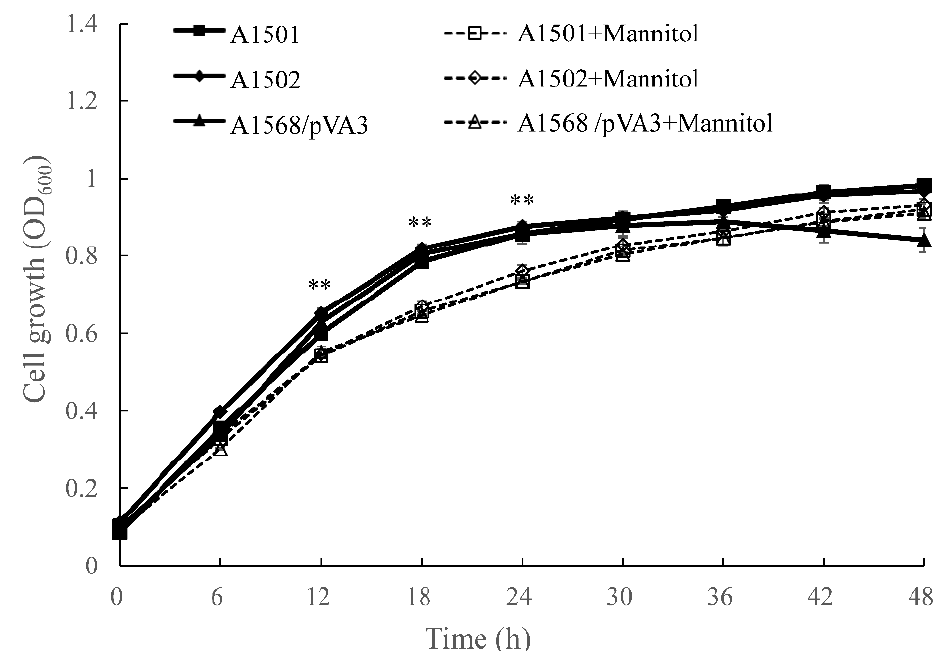
Figure 1. Influence of mannitol on the bacterial growth rates of wild-type P. stutzeri A1501 and two mutant derivatives, including the ammonium-excreting strain 1568/pVA3 and the nifH -mutant 1502. Data are means ± SE ( n = 3). Different letters above the boxes indicate a significant difference ( p < 0.05). The statistical analysis was carried out with ANOVA followed by the Duncan test. ** p value ≤ 0.01. All values are means ± SE (n = 3). Table 1. Qualitative analysis of the phosphate solubilization ability, IAA production, ammonium excretion, and ACC deaminase and nitrogenase activity of the P. stutzeri A1501 wild-type strain, the ammonium-excreting strain 1568/pVA3, and the nifH -mutant 1502. n.d.—not detected. Different letters (a–c) indicate a significant difference ( p < 0.05) according to ANOVA analysis.